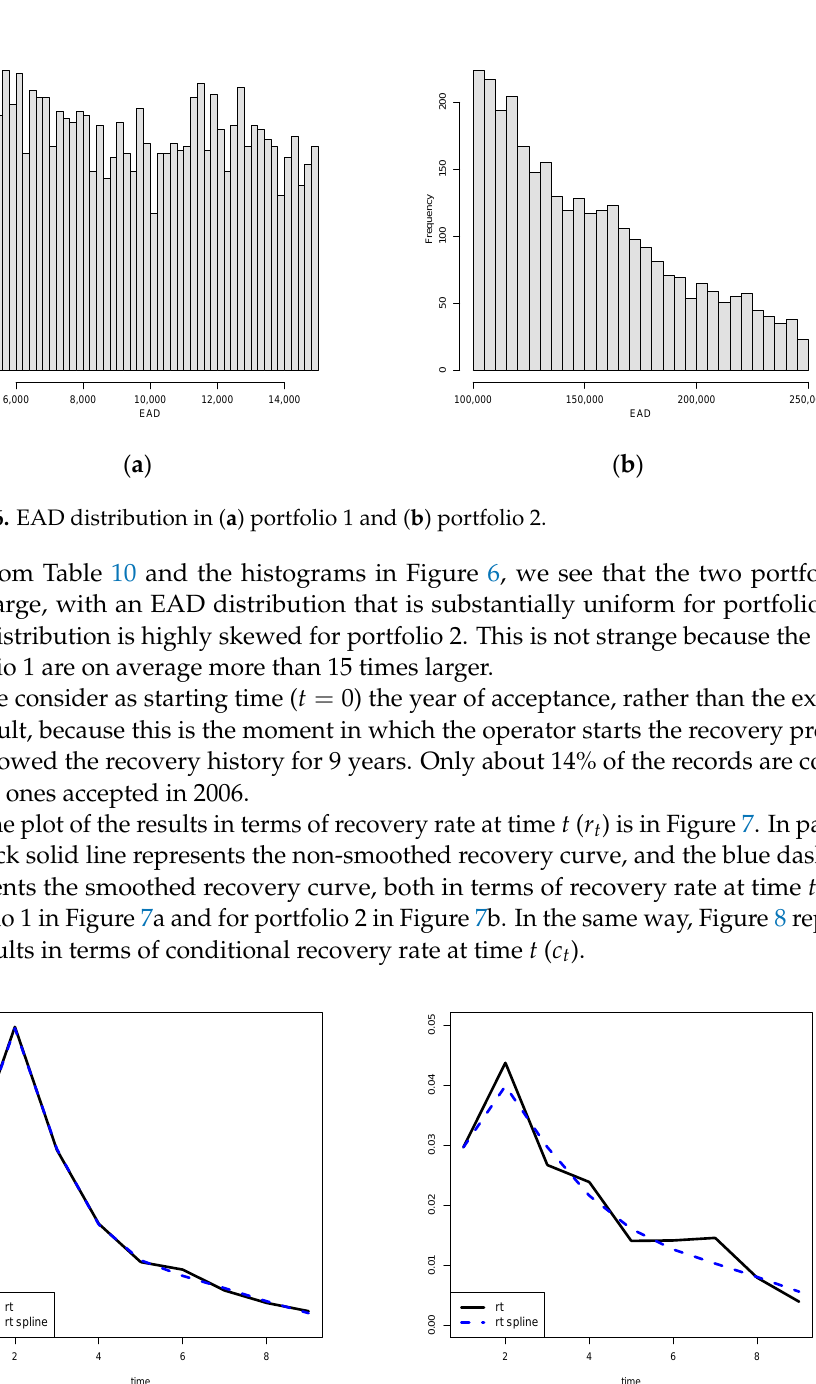
( b ) Figure 8. Conditional recovery rate at time 𝑡 ( 𝑐 (cid:3047) ) smoothed and non-smoothed for ( a ) portfolio 1; and ( b ) portfolio 2. From Figures 7 and 8, we see that, as expected, the highest values of the recovery are at the beginning of the observation period, meaning that the procedures put in place by specialized operators obtain a significant effect as soon as the debt is processed, while as time passes, the recovery tends to decrease. It is interesting to note that the highest recovery is obtained in 𝑡 = 2 rather than 𝑡 = 1 . This is probably because the recovery procedures that the operator implements require a certain amount of time to reach their maximum efficiency. It is important to say that in order to “learn” from the data the peak in 𝑡 = 2 , we applied the regression splines only in the range 𝑡 = 2: 9 . To compare the results, it is useful to draw the curves of both portfolios on a single plot. In Figures 9–11, we represent the smoothed recovery curves for portfolio 1 with a black solid line and for portfolio 2 with a blue dashed line in terms, respectively, of recovery rate at time t ( 𝑟 (cid:3047) ), conditional recovery rate at time t ( 𝑐 (cid:3047) ), and recovery rate until time t ( 𝑅 (cid:3047) ).